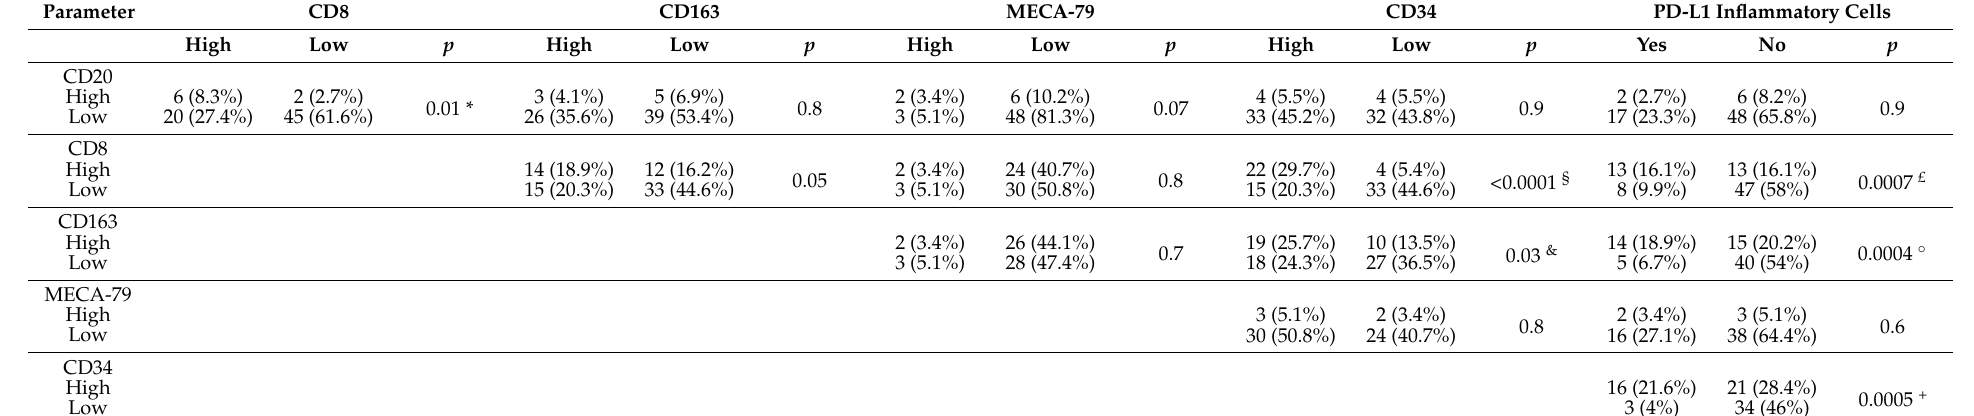
Table 3. Immunohistochemical